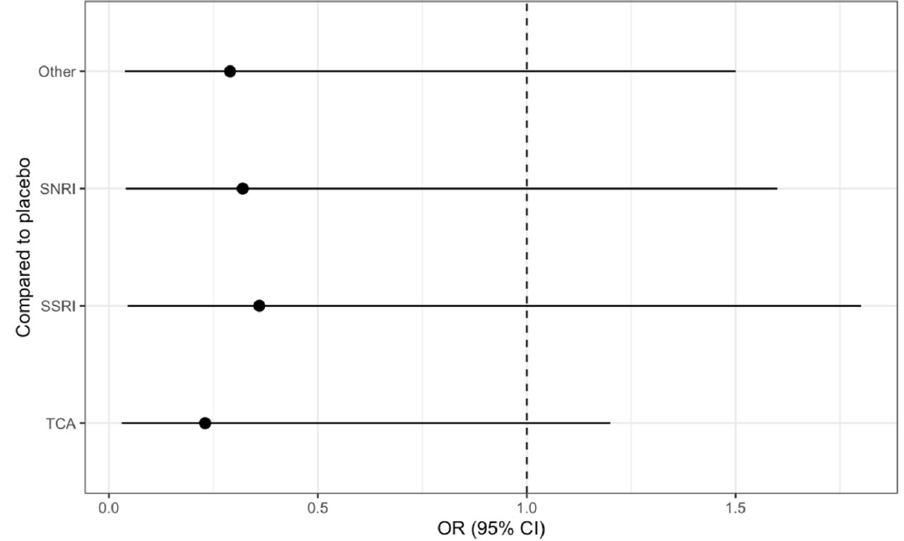
Figure 3. Forest plot demonstrated the relative effect of antidepressants compared to placebo.